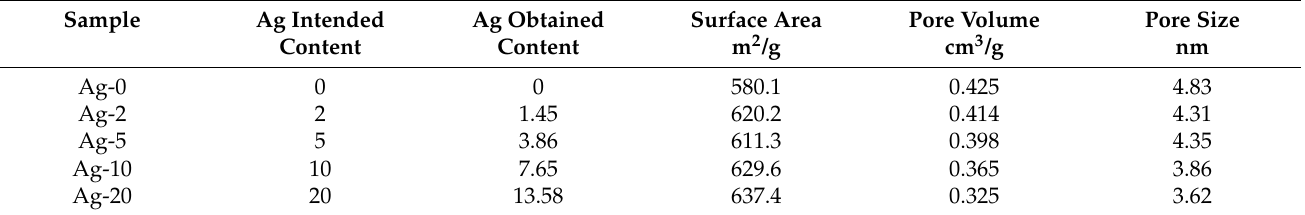
Table 1. The exact amount of silver as obtained from ICP-OE and the textural properties of the prepared as obtained from N 2 sorption